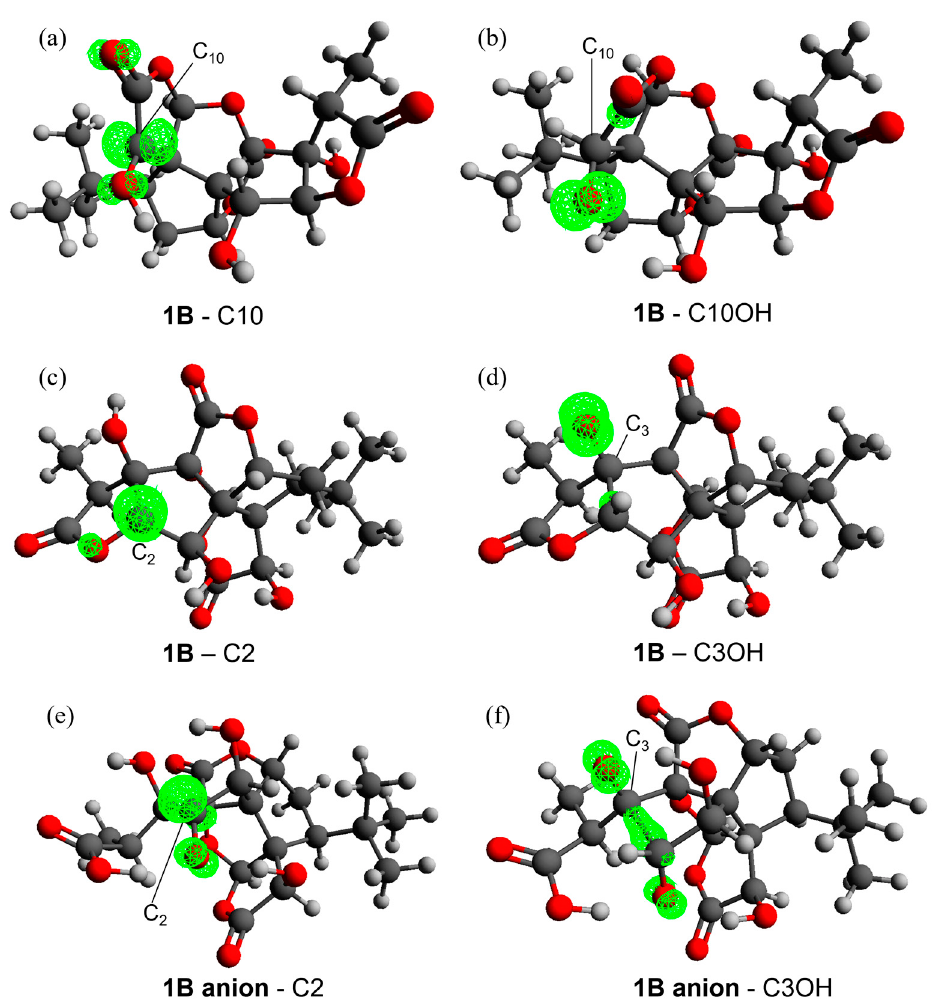
Figure 2. Spin densities on the radical products of 1B when HAT occurs from C10 ( a ), C10OH ( b ), C2 ( c ) and C3OH ( d ) and on the 1B anion radical when HAT occurs from C2 ( e ) and C3OH ( f ) with an isosurface value of 0.02. Level of theory: M06-2X/6-311+G(d,p)//M06-2X/6-31G(d).